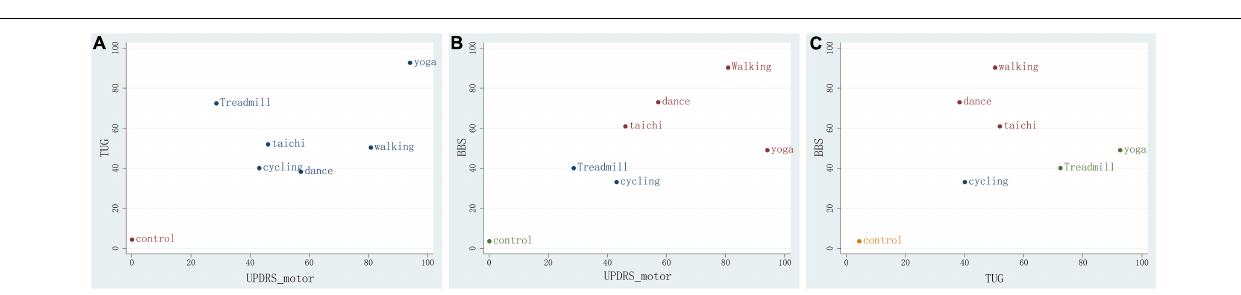
FIGURE 5 | Clustered ranking plot of the network. (A) For UPDRS-motor&TUG outcomes. (B) For UPDRS&BBS. (C) For TUG&BBS outcomes. The plots are based on cluster analyses of SUCRA values. Each plot shows the SUCRA values for two different outcomes. The therapies in the upper right corner are more effective than the other